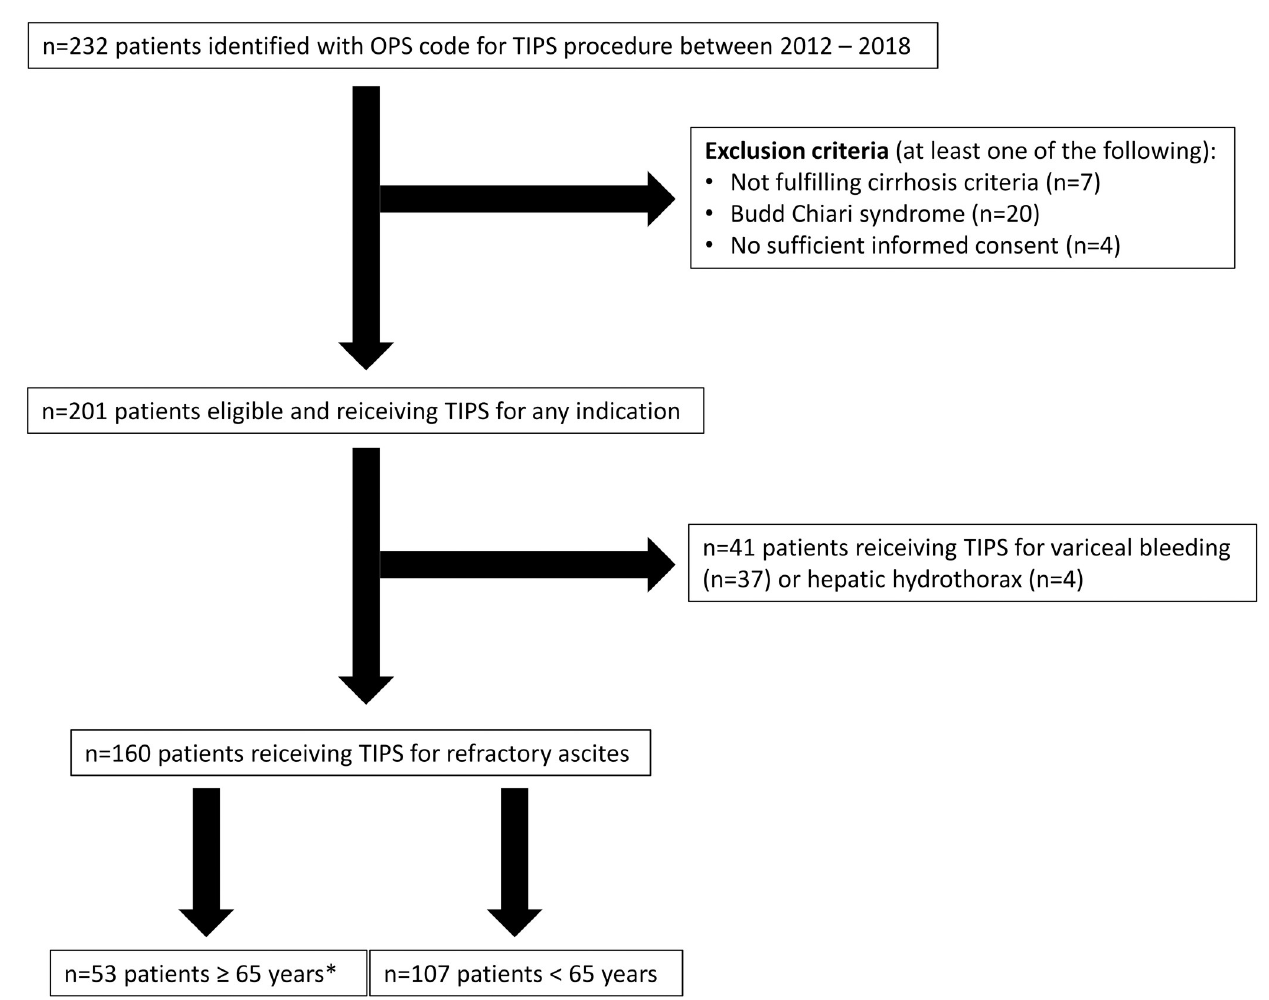
Fig 1. Patient selection algorithm and distribution of patients‘ age. � n = 14 patients of the elderly subgroup were � 75 years. Abbreviations: OPS: operation and procedure code.